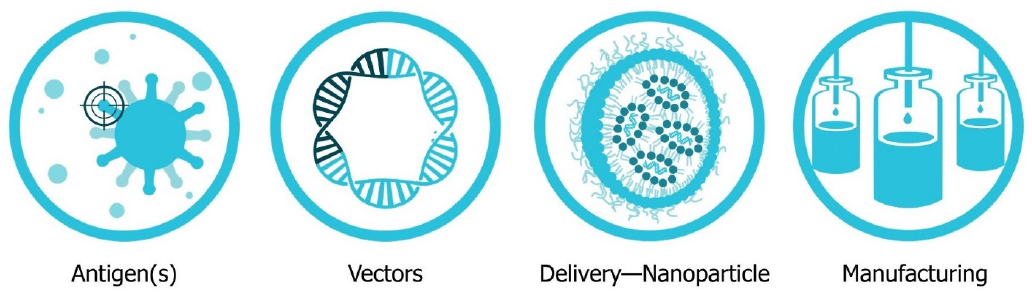
Figure 2. The Four Pillars of successful saRNA vaccine development. The antigens, vectors, delivery and manufacturing each represent modular components that need to be combined to make a successful drug product. Each pillar has its set of design and development considerations and associated technologies that are explored in this review.